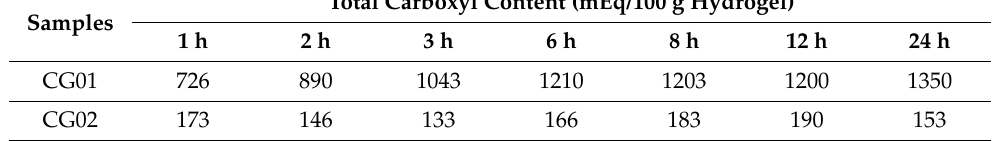
Figure 3. Total carboxyl content of CG01 and CG02 for different immersion times in crosslinker solution at room temperature. The results p < 0.0001(****) were considered as significant in com- pared to CG02. Table 1. Total carboxyl content of CG01 and CG02 based on different immersion times in crosslinker solution.